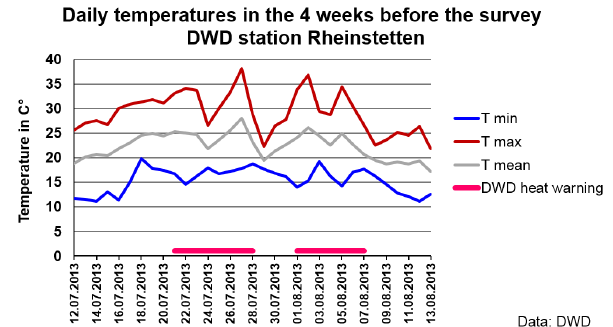
Figure 1. Daily temperatures in Karlsruhe (German Weather Ser- vice DWD station Rheinstetten) and days with heat warnings issued by the DWD for